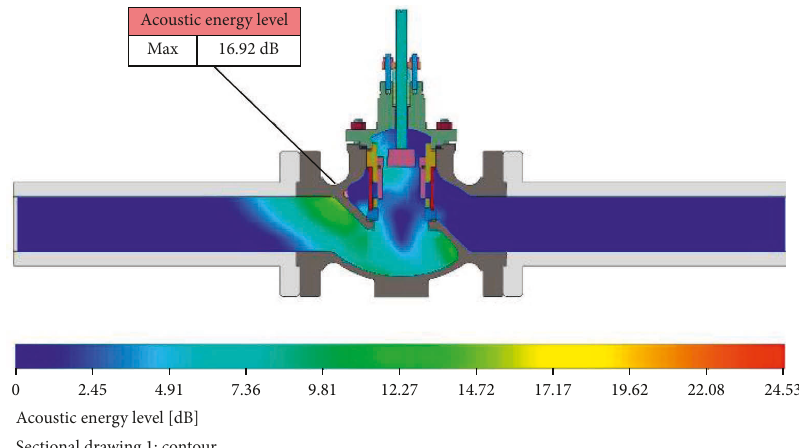
Figure 29: Acoustic energy level cloud map for 40%